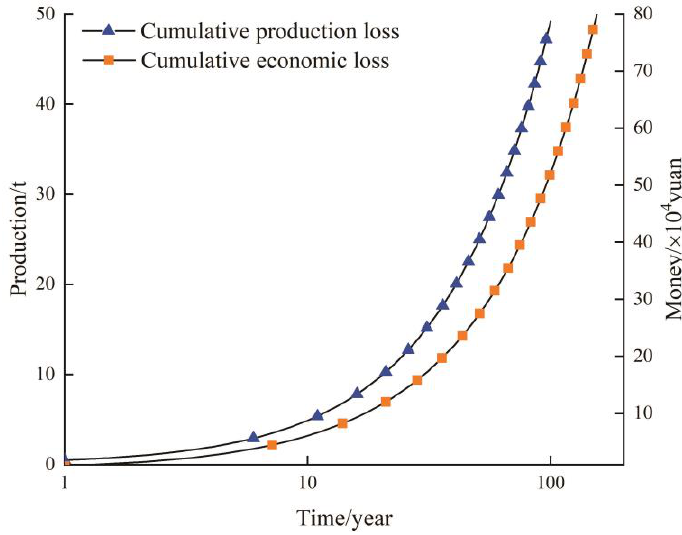
Figure 6. Cumulative loss of output and money over time.